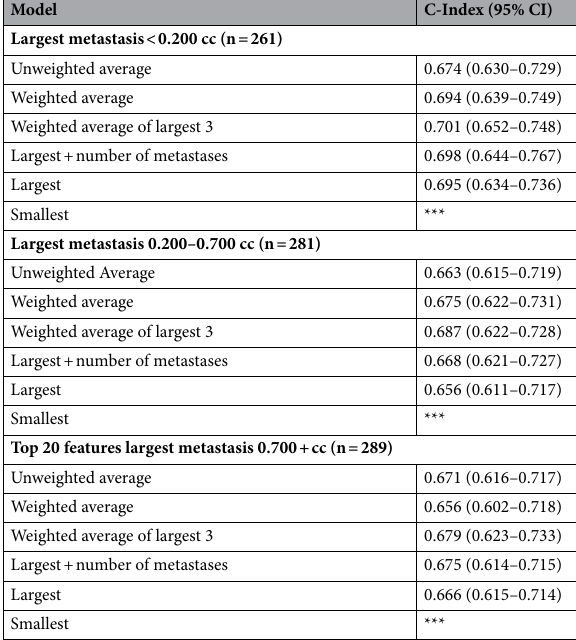
Table 4. Sub-analysis: volume of largest metastasis.